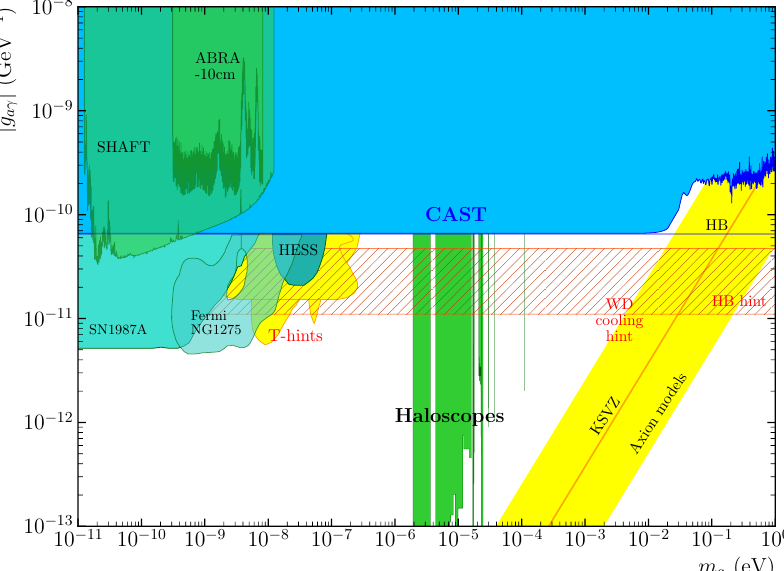
Figure 2. The present axion searches experimental landscape showing the reached sensitivity in terms of the axion-photon coupling, g a γ , for different experimental searches (CAST [56], Haloscopes[57], SHAFT[58], and ABRA-10cm[59]). Together with the different astrophysical constraints (SN1987A, HB, HESS, and Fermi-LAT) and astrophysical hints (T-hints, WD cooling hints, and HB hint) already described in Section 3. The yellow band denotes the region of the parameter space favoured by QCD axion models. An up-to-date picture and detailed axion parameter space can be found at